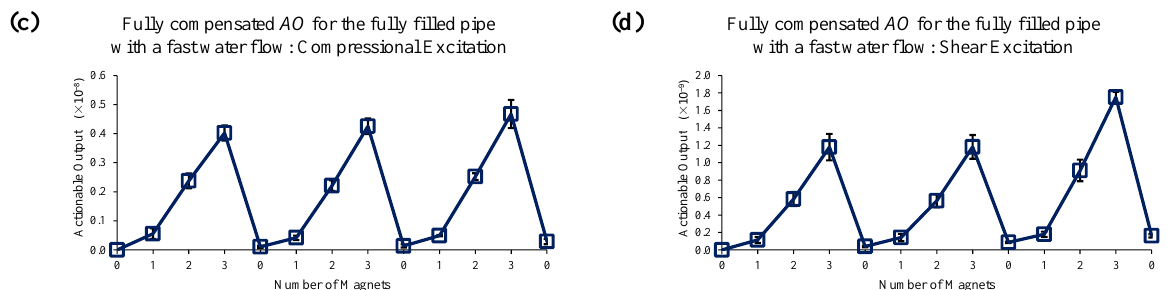
Figure 19. Changes in AO under fast water-flow conditions with the different number of magnet perturbations for the half-filled pipe with ( a ) compressional and ( b ) shear excitations; and the fully filled pipe with ( c ) compressional and ( d ) shear excitations. The full, two-level EOC compensation method is applied.